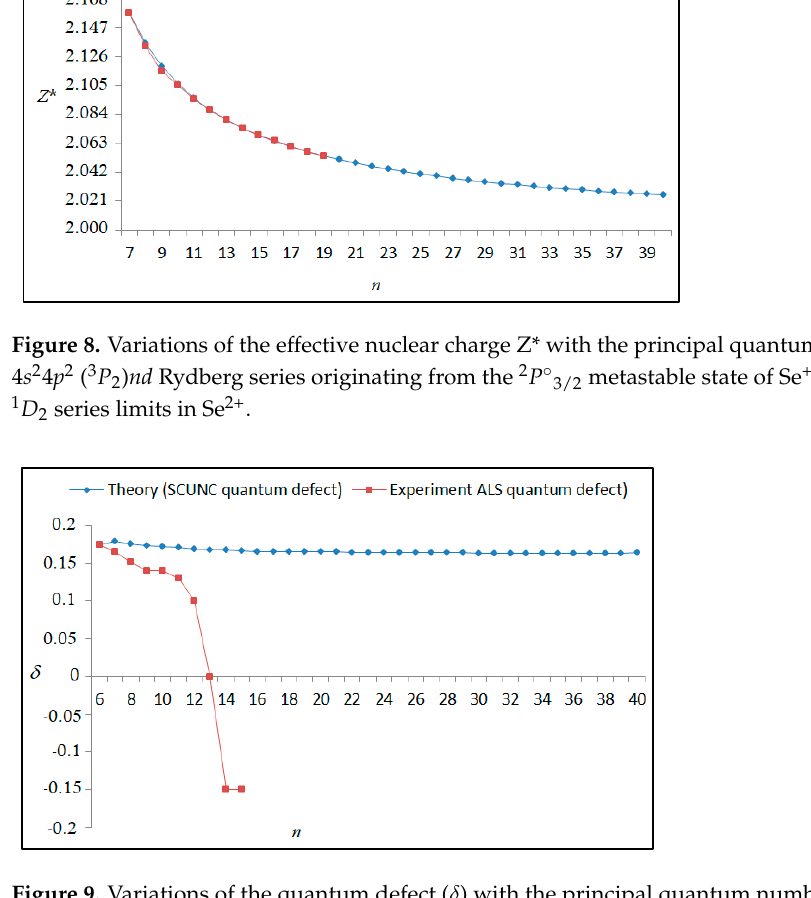
Figure 10. Variations of the effective nuclear charge Z* with the principal quantum number n for the 4 s 2 4 p 2 ( 1 D 2 ) nd ( 2 P 1/2 ) Rydberg series originating from the 2 P ° 1/2 metastable state of Se + converging to the 2 D 1 series limits in Se 2+ . Table 6. Energy resonances ( E ), quantum defect ( δ ) and effective charge ( Z *) of the 4 s 2 4 p 2 ( 1 D 2 ) nd ( 2 S ) Rydberg series originating from the 4 s 2 4 p 3 2 P ° 1/2 metastable state of Se + converging to the 3 P 2 series limit in Se 2+ . The present results (SCUNC) are compared with the experimental data from ALS measure- ments [6]. The uncertainties in the experimental energies are stated to be ±0.010 eV, f 1 ( 1 D 2 ; 2 S ; 2 P ° 1/2 ) = − 0.165 ± 0.033 with ν = 6. Initial Se + State: 4 s 2 4 p 3 2 P ° 1/2 SCUNC ALS n